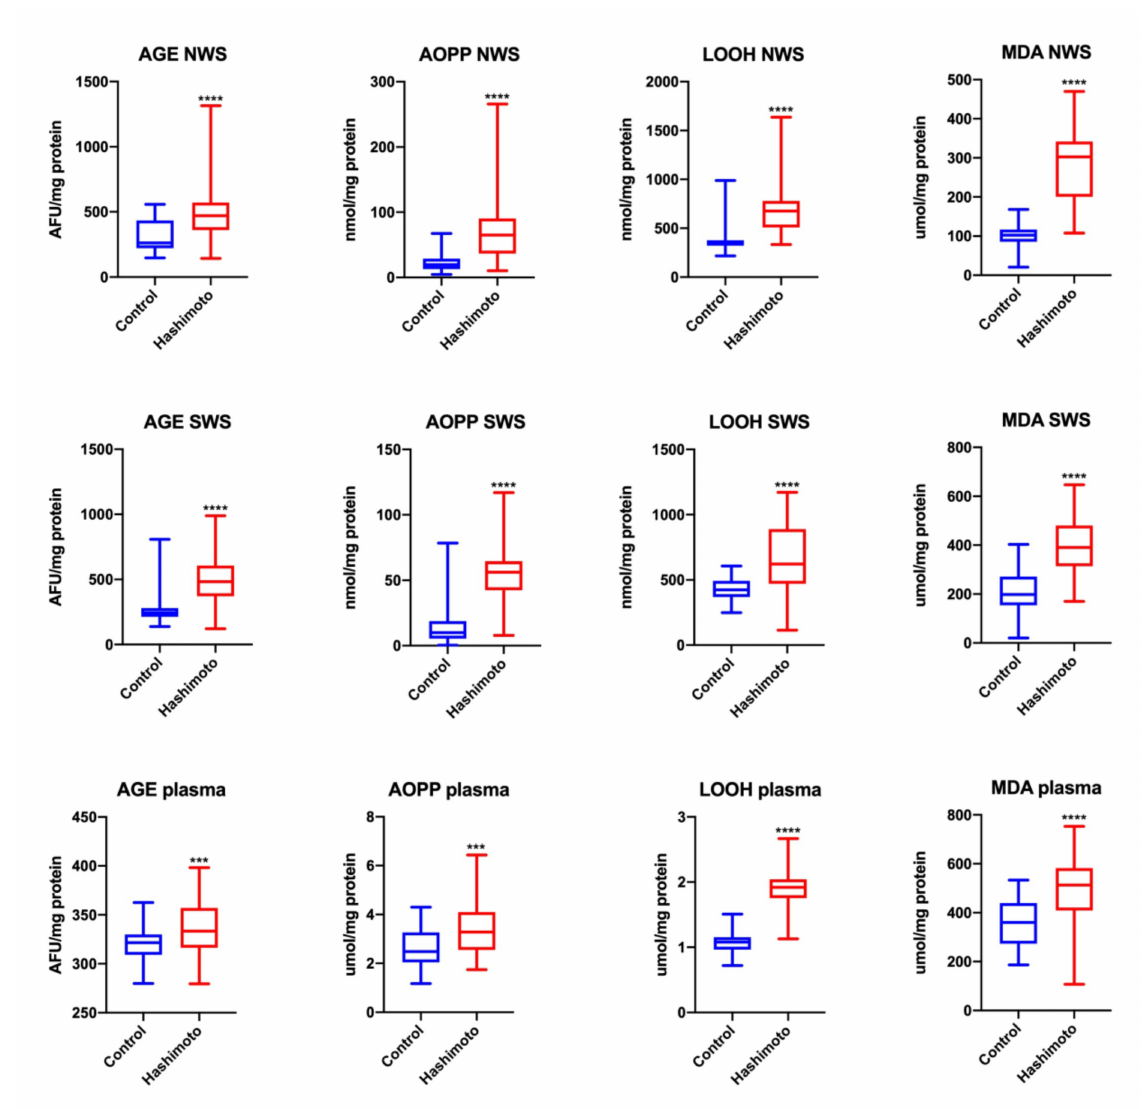
Figure 3. Oxidative damage in NWS, SWS and plasma of the patients and control group. Data are shown as median